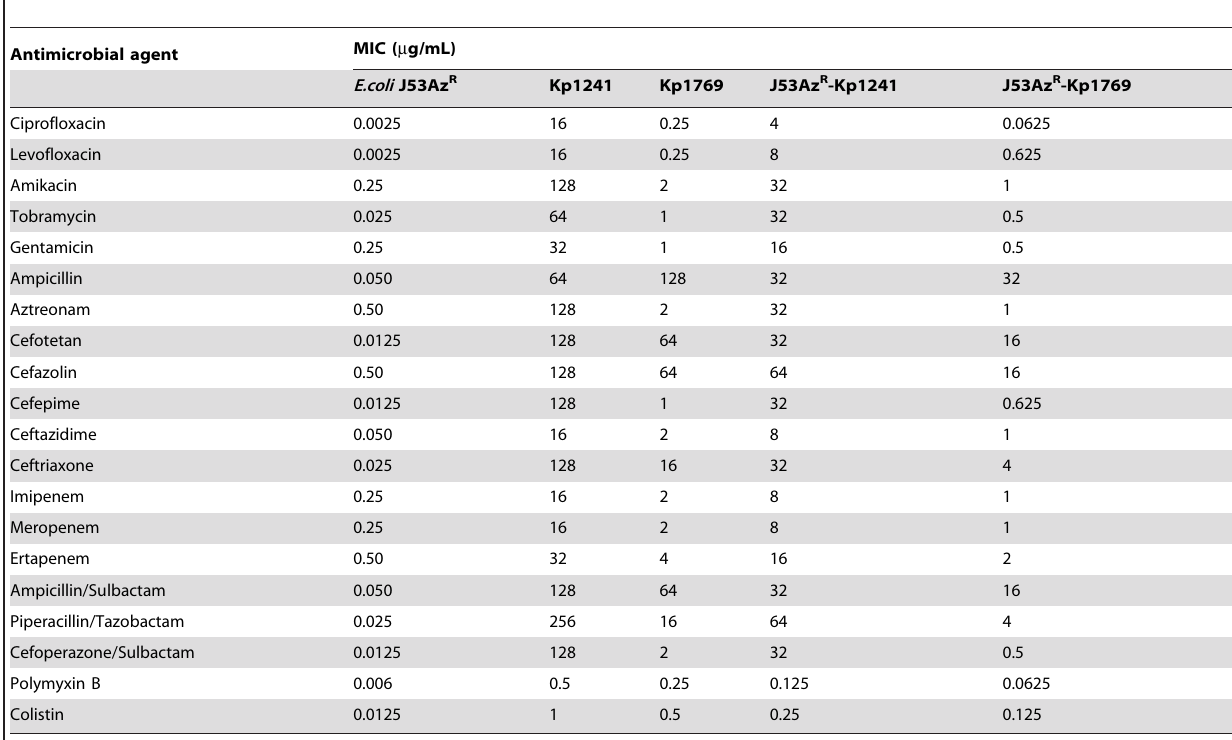
Table 2. The susceptibility for strains of E. coli J53Az R , Kp1241, Kp1769, and transconjugants (J53Az R -Kp1241 and J53Az R -Kp1769).